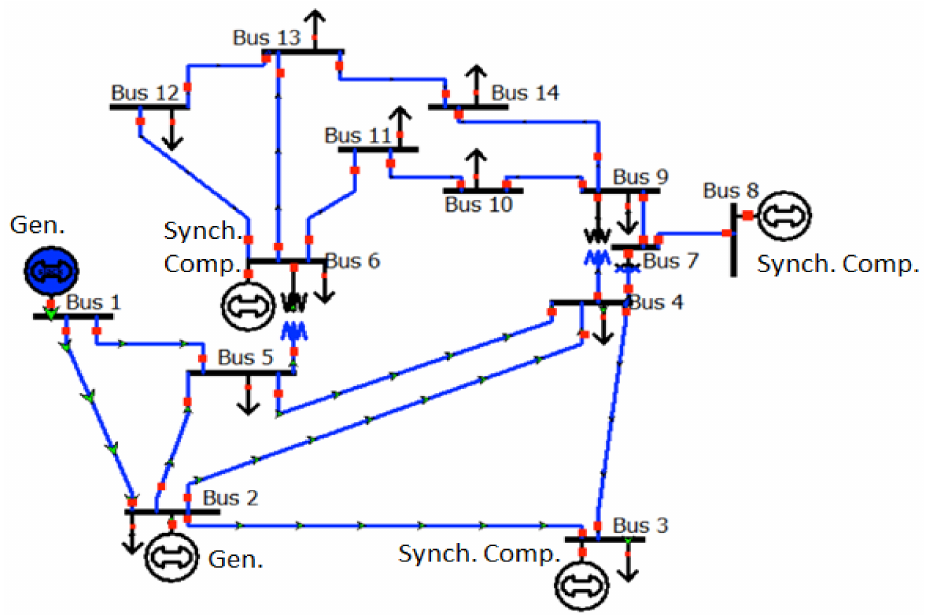
Figure 1. Line diagram of IEEE 14-bus